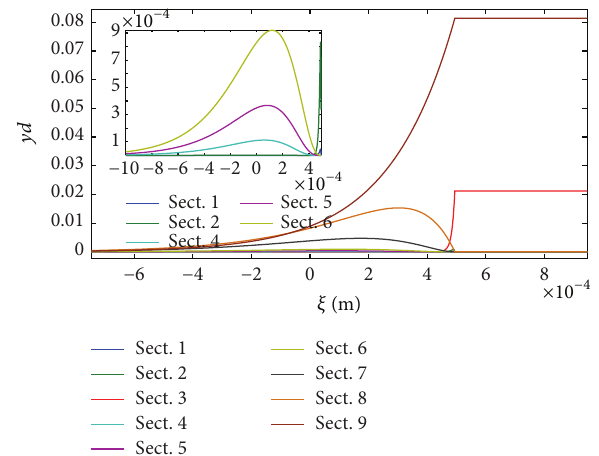
Figure 9: Liquid fuel sectional mass fractions profiles in one- dimensional laminar spray flame propagation, initial size distribu- tion 2.